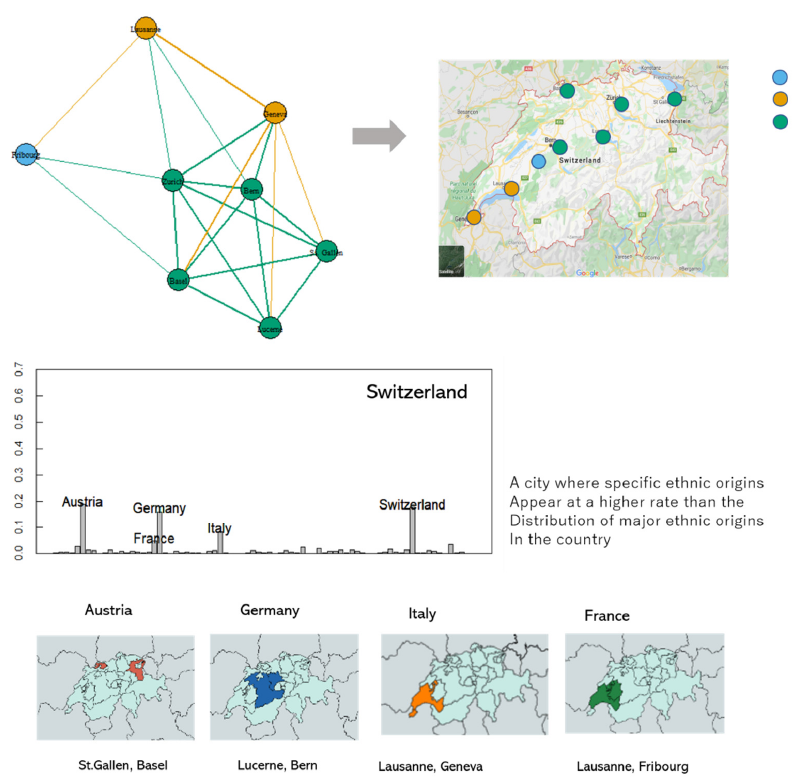
Figure 10 Spatial distribution of ethnicity in Switzerland. [33,34] Figure 10. Spatial distribution of ethnicity in Switzerland